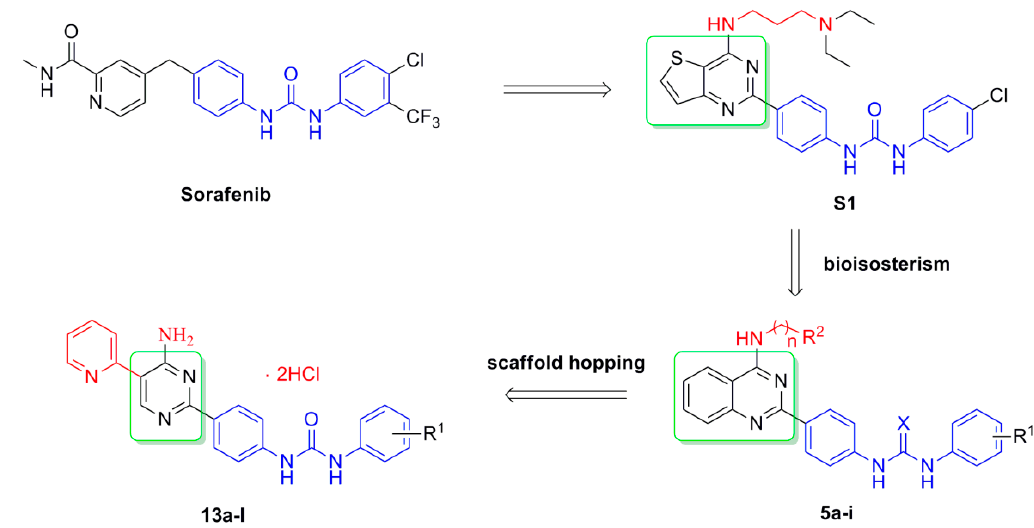
Figure 2. Design of target compounds.